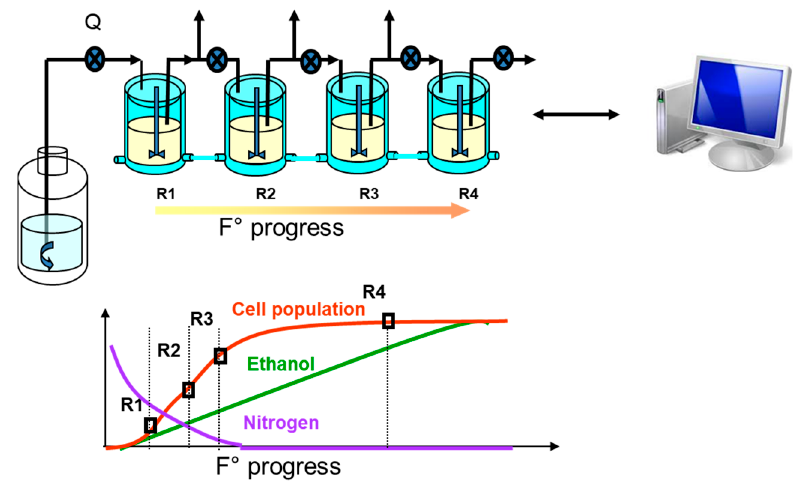
Figure 6. Schematic representation of the four-stage continuous fermentation device. The system is made up of four tanks (R1 to R4) linked in series. The five pumps are monitored independently by the control software, which also integrates the data coming from the mass flowmeters. Each bioreactor, except the first one, is fed with cells and partially fermented medium from the previous tank. The first stages are run with growing cells, while the last ones operate as resting cells. This device reproduces batch fermentation characteristics.